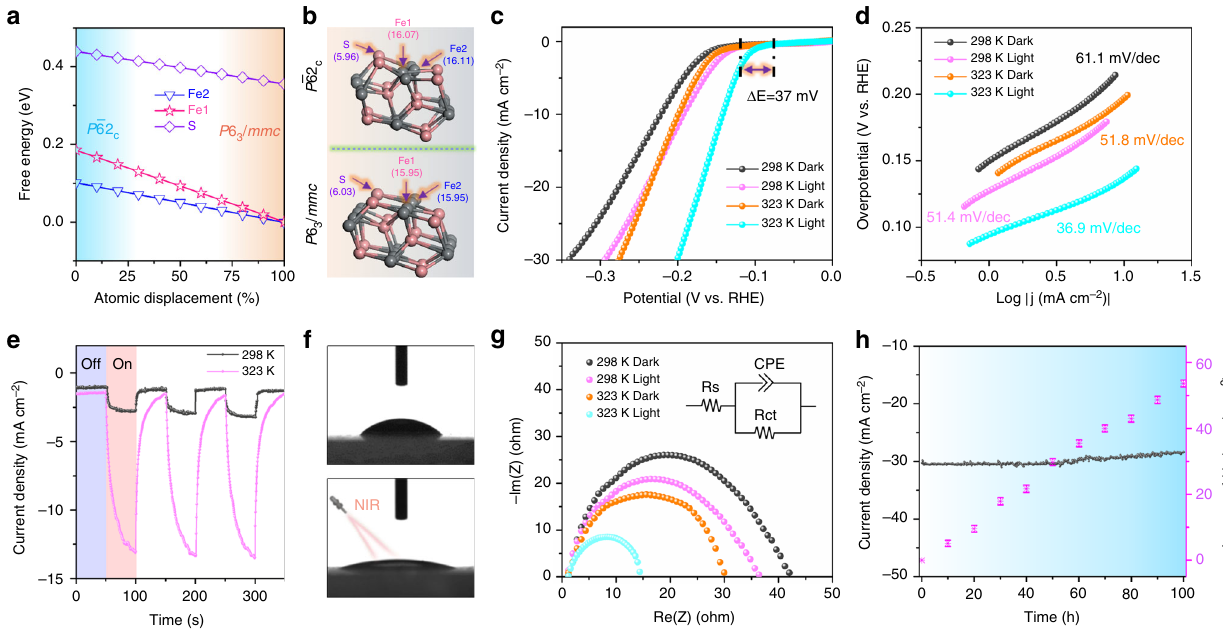
Fig. 4 Practical application of HER. a The Gibbs free energy as a function of the fraction of the atomic distortion between the P (cid:1) 62 c (0%) and P 6 3 / mmc (100%) phase. b Atomic structural models of FeS (100) surface for P 6 3 / mmc phase (bottom panel) and its corresponding surface in P (cid:1) 62 c phase (top panel), in which the Mulliken charges are also marked. c Polarization curves and d Tafel plots of the FeS/CFC at different temperatures with or without NIR light irradiation. e Amperometric I – t curves under chopped NIR light irradiation at different temperatures. f The differences in hydrophilicity with or without NIR light irradiation using contact angle measurement. g EIS curves in dark and light fi elds at different temperatures with an equivalent circuit (inset). h Chronoamperometry curve (left) of the FeS/CFC at a constant potential of − 0.2V (vs. RHE) accompanied by the continuous hydrogen measurement